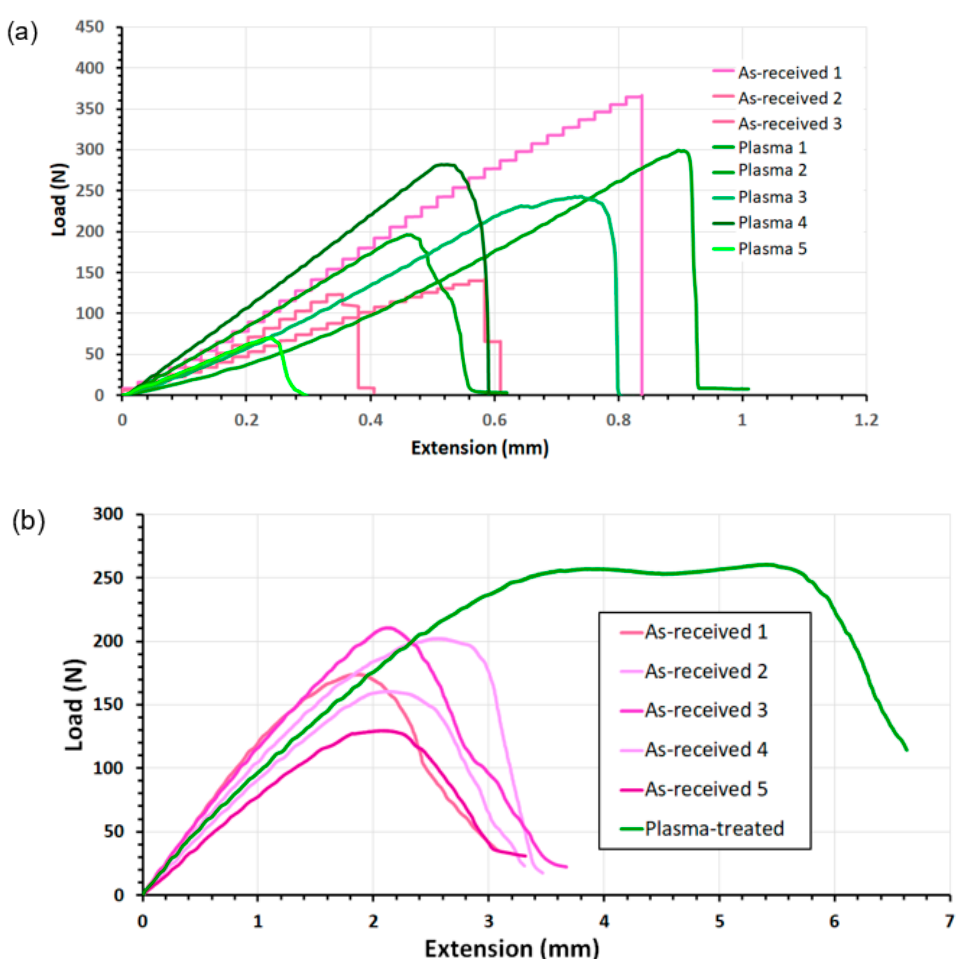
Figure 15. Binding strength as a function of extension of single-joint lap shears made with ( a ) EPON 825/JEFFAMINE D-2000 epoxy and ( b ) Sikaflex under different treatment conditions: untreated nylon, after plasma treatment, and after plasma and silane treatments. Multiple samples were tested for each nylon surface condition.